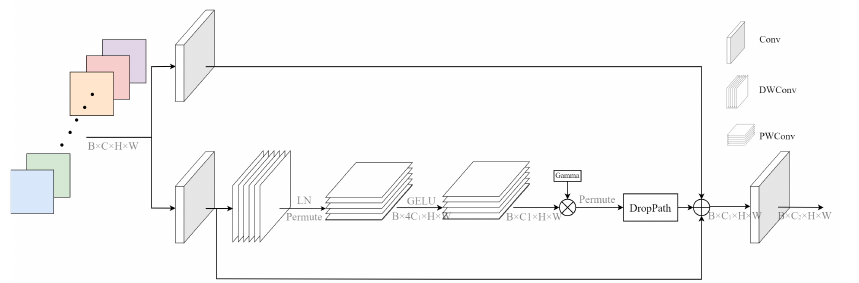
Figure 5. Diagram illustrating the CDPB module’s structure, utilizing DWConv and PWConv structures in place of the original convolutional layers (We have chosen kernel_size equal to three, and the CDPB is about one-ninth the computational effort of full